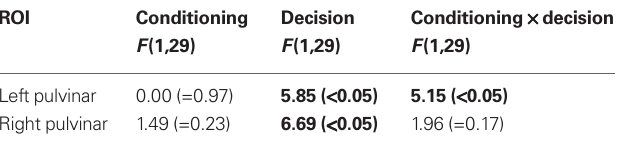
Table 1 | Mean-response based analysis in the Pulvinar. ( P -values in parentheses; values in bold font are statistically significant at the 0.05 level.)